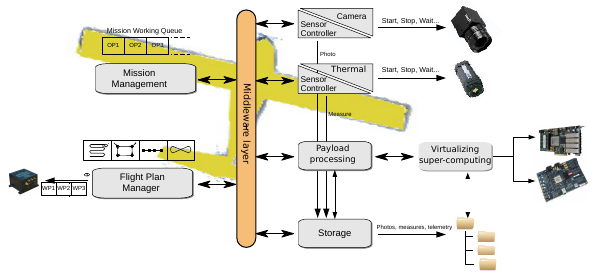
Figure 8: Virtualizing super-computing architecture